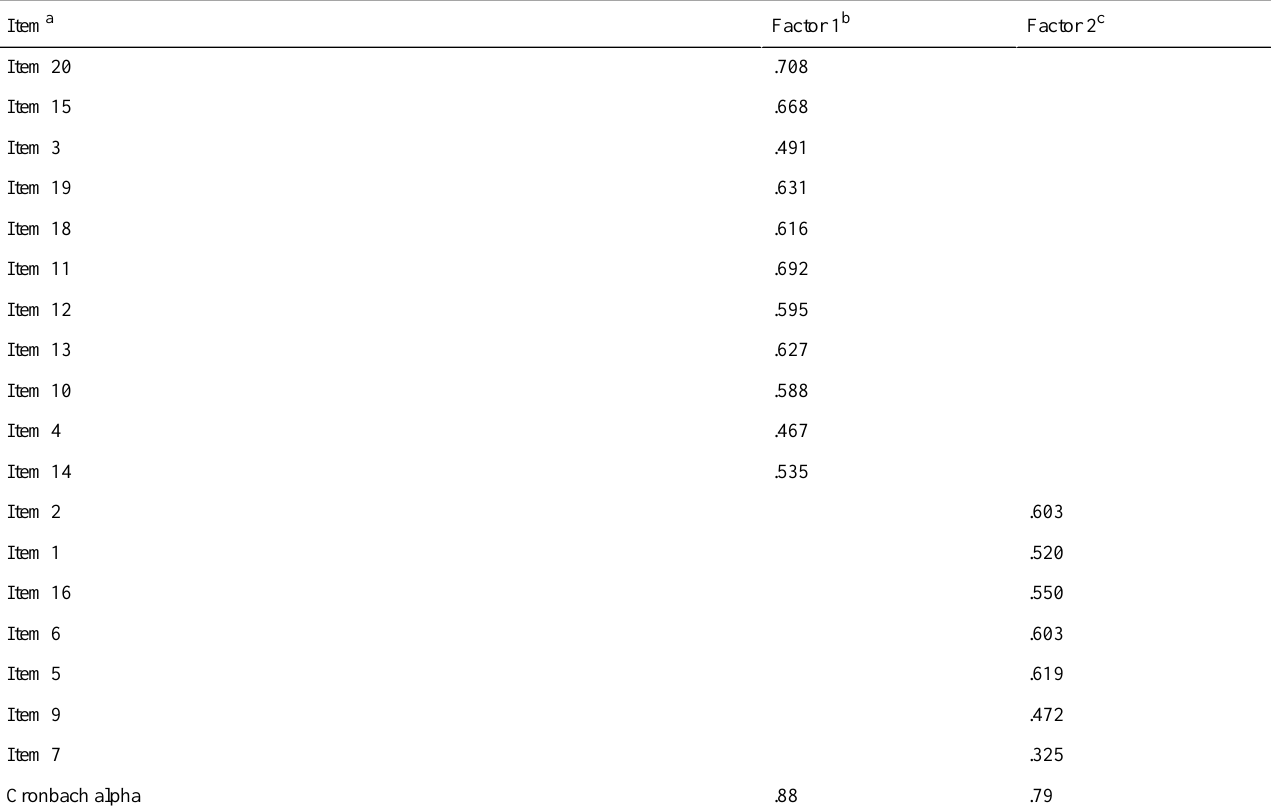
Table 3. Corrected item-total